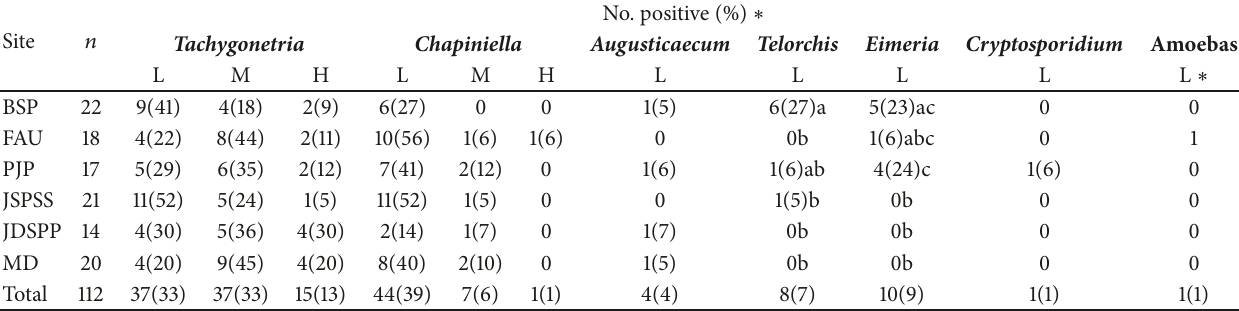
Table 2: Qualitative intestinal parasite loads approximated via egg counts in adult and subadult gopher tortoise ( Gopherus polyphemus ) fecal samples from six populations in South